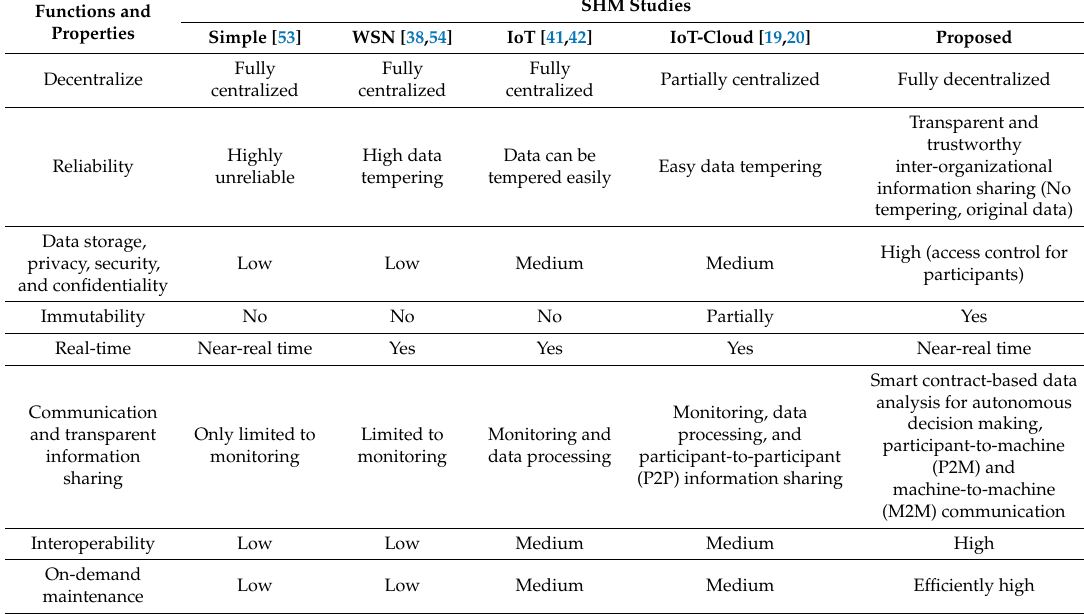
Table 3. Comparison of functions of the proposed blockchain-IoT network with traditional structural health monitoring (SHM)